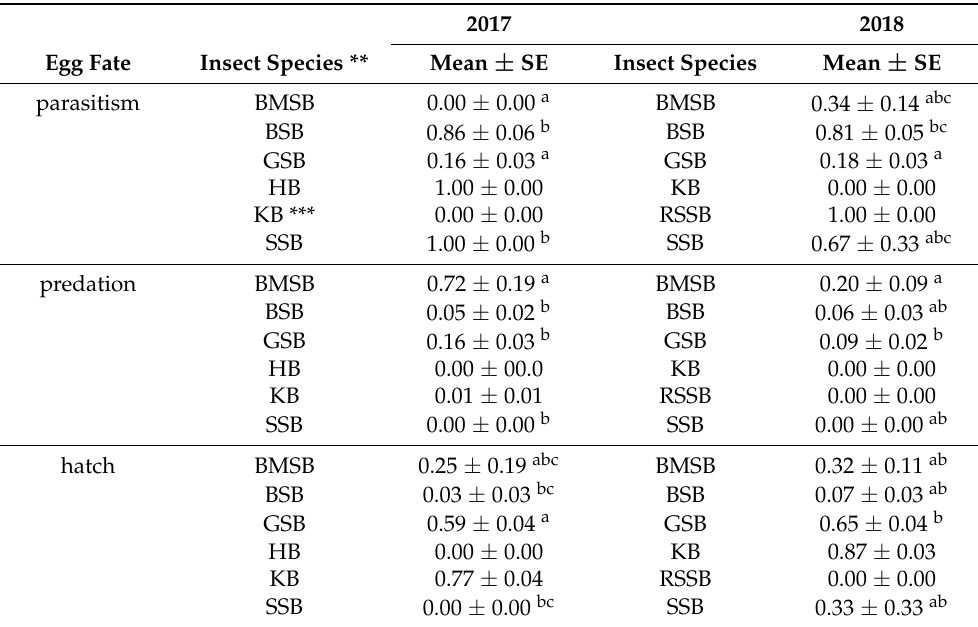
Table 5. Percentage of stink bug egg mortality due to parasitism and predation, and proportion of hatched individuals in soybean plots during 2017 and 2018, at one field site, Beltsville [Central Maryland (CM)]. Data are compared between species. Mean values and standard errors (Mean ± SE) and results of statistical comparisons via fitted GLMMs and LMMs are